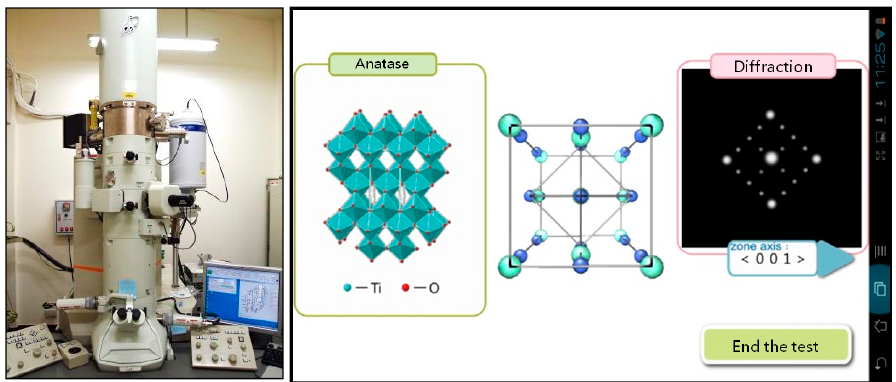
Figure 2. Using the TEM to observe a material’s crystal structure.